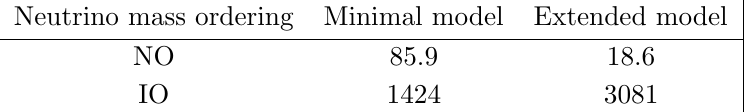
Table 3 . Values of the (cid:31) 2 function corresponding to the best (cid:12)ts for the two models and for both normal (NO) and inverted (IO) neutrino mass